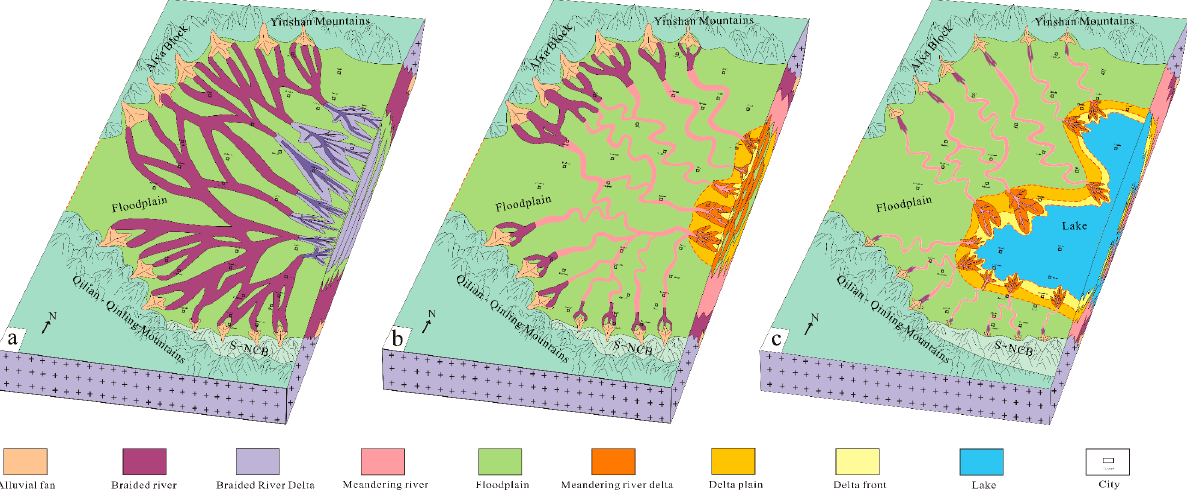
Figure 8. Sedimentary filling evolution map of Jurassic Zhiluo Formation in Ordos Basin: ( a ) Sedi ‐ mentary filling evolution map of the J 2 z 1 ‐ 1 ; ( b ) Sedimentary filling evolution map of the J 2 z 1 ‐ 2 ; ( c ) Sedimentary filling evolution map of the J 2 z 2